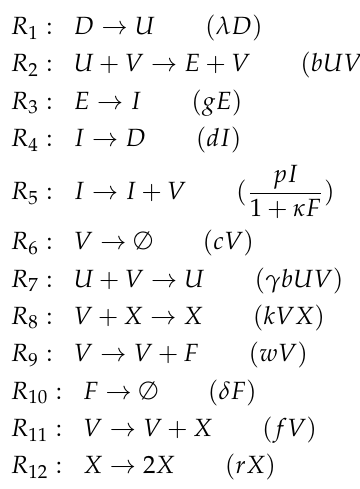
Figure A5. Reactions of Handel model